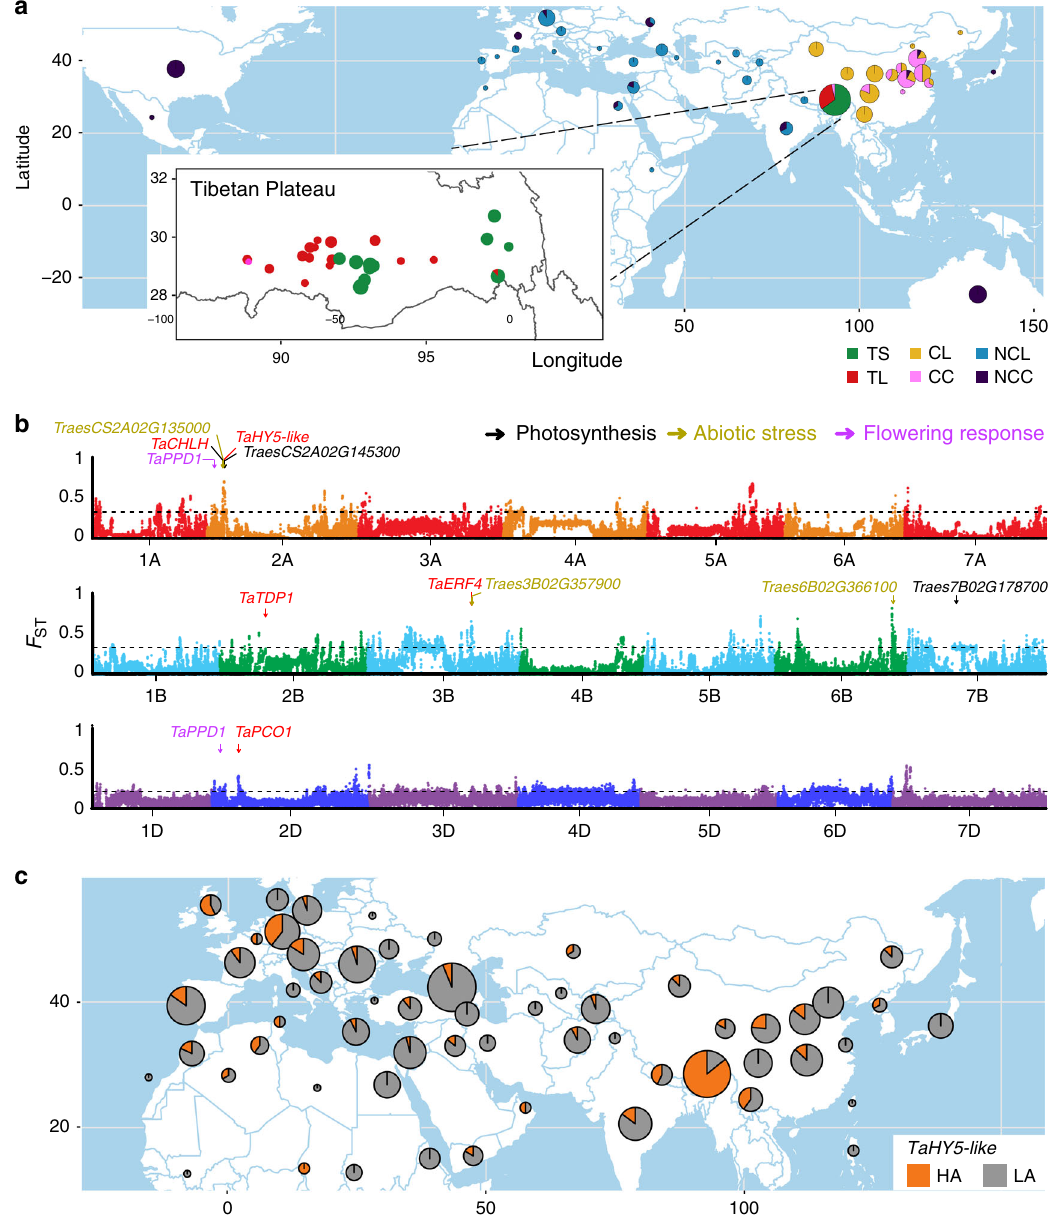
Fig. 2 Geographic locations and candidate regions responsive to high-altitude extremes. a Global distribution of wheat accessions. NCL, Non-Chinese landrace; NCC, Non-Chinese cultivar; CL, Chinese landrace (excluding Tibetan landrace); CC, Chinese cultivar; TS, Tibetan semi-wild wheat; TL, Tibetan landrace. b Genome-wide distribution of genetic differentiation regions between high-altitude (HA) and low-altitude (LA) wheat accessions identi fi ed by F ST analysis. Each point indicates a 100k-bp window. Dashed lines indicate the top 5% thresholds. Key candidate genes are labeled with arrows. c Geographic distribution of different haplotypes of TaHY5-like gene. The haplotype distribution analysis was determined using 308 resequencing accessions and 1026 wheat whole-exome capture samples. Orange indicates the proportion of HA adapted haplotype of TaHY5-like gene. HA, high-altitude wheat accessions. LA, low-altitude accessions. Geographic maps in a and c were generated using R packages, including maps, ggmaps, ggplot2, and sf, with geographic information data edited from original version of the Natural Earth project database (version 2013). Source data underlying Fig. 2b are provided as a Source Data fi